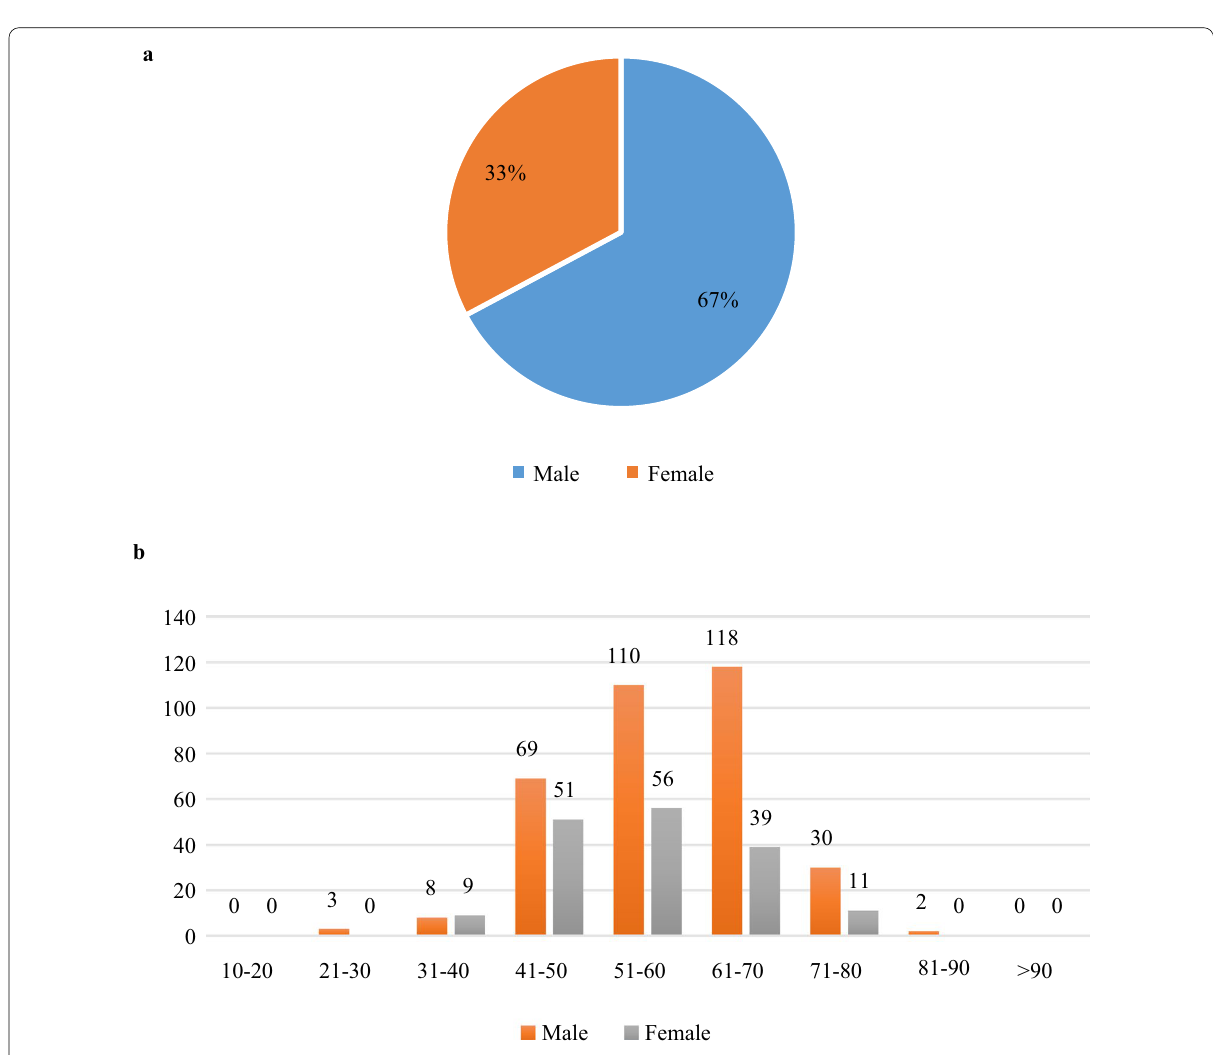
Fig. 5 Distribution of patients included in the dataset of whole-body scintigraphic images. a Gender; and ( b ) age